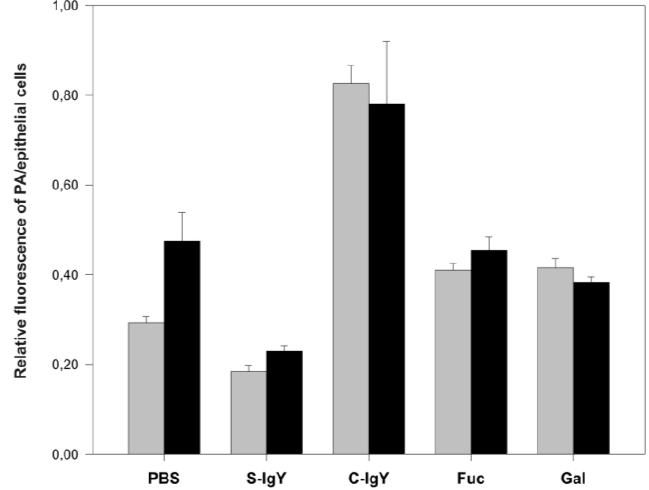
Figure 5. Adhesion of PA to epithelium cells in the presence of IgYs and saccharides. Monolayers of NuLi (grey bars) and CuFi (black bars) were exposed to PA suspension containing anti-PAIIL IgY ( S-IgY ), pre-immune IgY ( C-IgY ), L -fucose ( Fuc ), D -galactose ( Gal ) or PBS as a control. After a 2-hour incubation non-adhered bacteria were discarded and retained PA and epithelial cells were quantified using spectrofluorometer (Tecan Infinite M200 Pro). Results are expressed as a relative fluorescence ratio of PA/NuLi or PA/CuFi. Plotted data are means ± SD of four independent